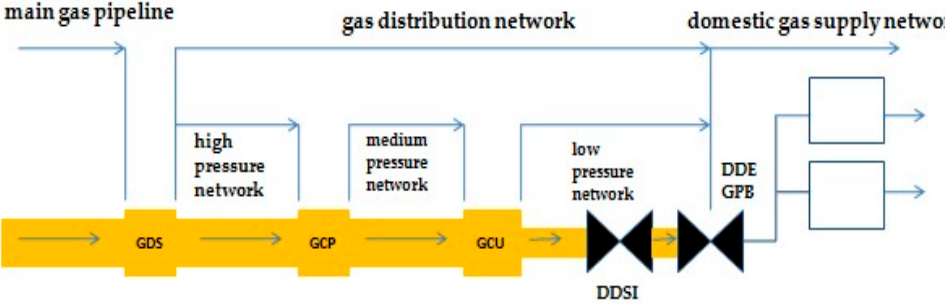
Figure 1. Schematic diagram of the urban gas supply system.